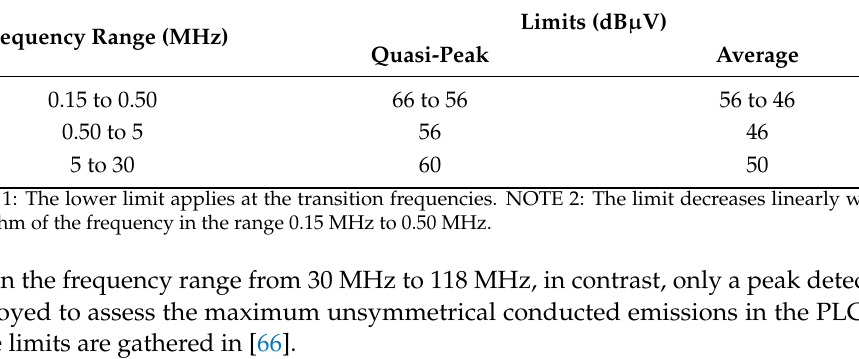
Table 2. General class B limits for conducted